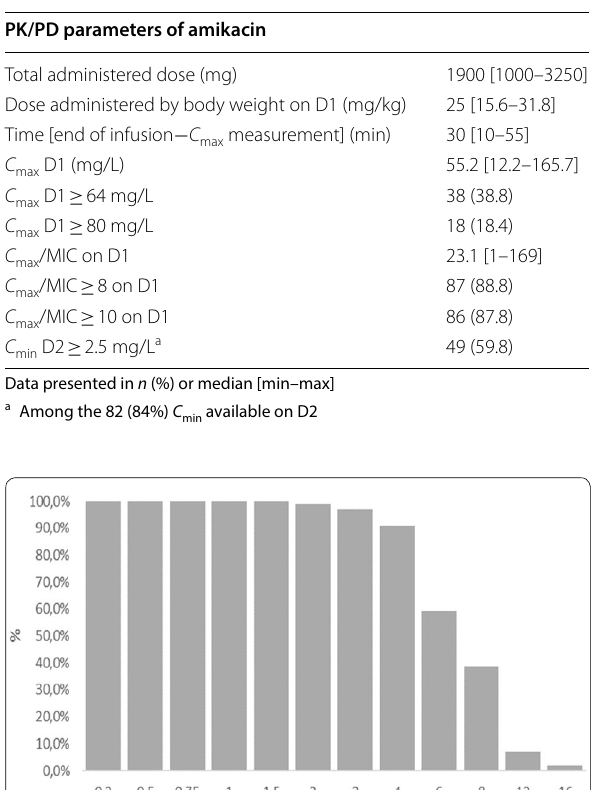
Table 2 Pharmacokinetic/pharmacodynamic parameters observed